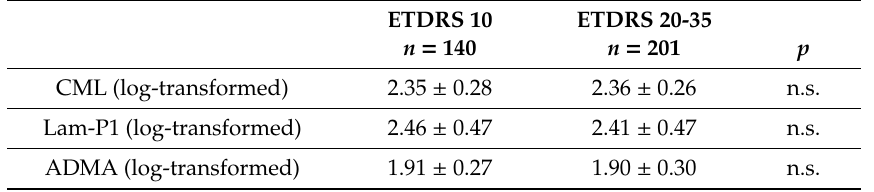
Table 3. Baseline serum levels of biomarkers compared to severity of DR (ETDRS classification).